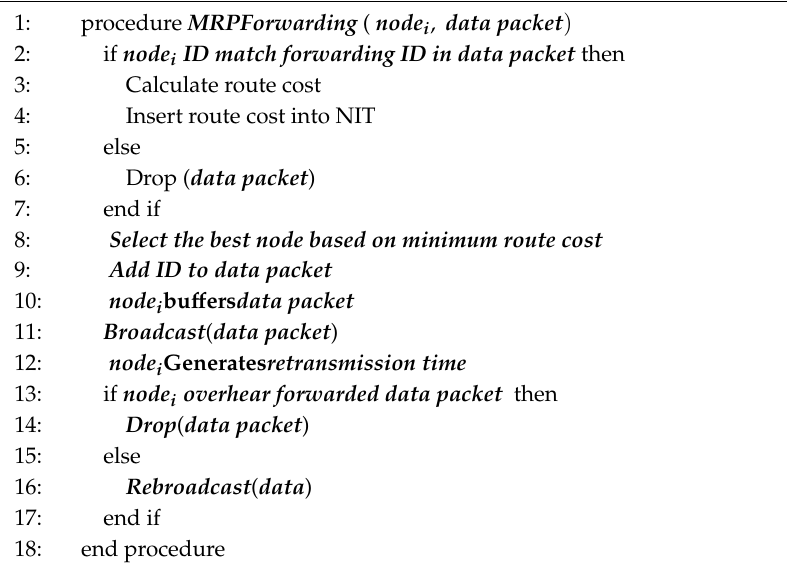
Algorithm 2. Data Forwarding